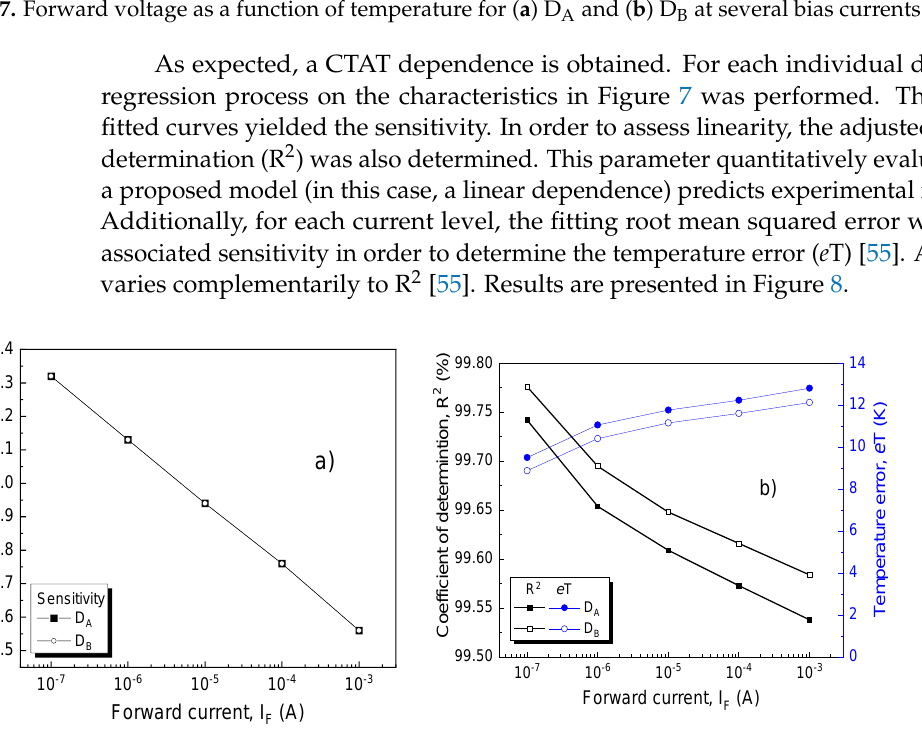
Figure 8. ( a ) Sensitivity, ( b ) coefficients of determination and average temperature error for both SiC Schottky diodes at different bias currents. For sensitivity, the absolute value was represented.